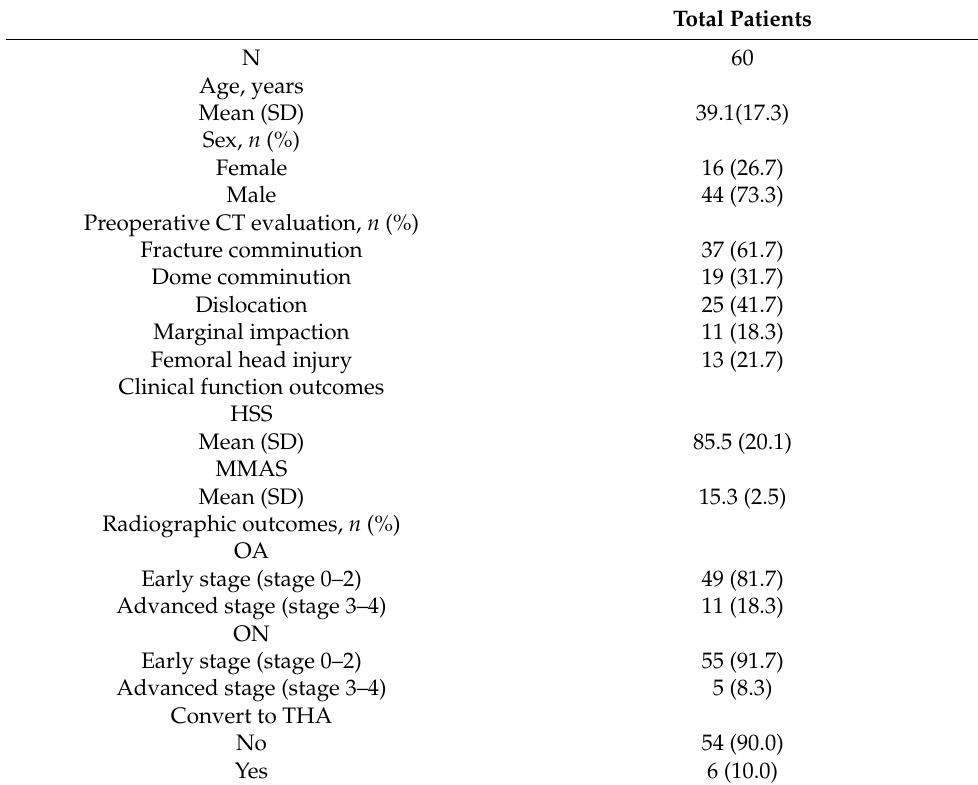
Table 1. The patients’ preoperative and postoperative clinical and radiographic